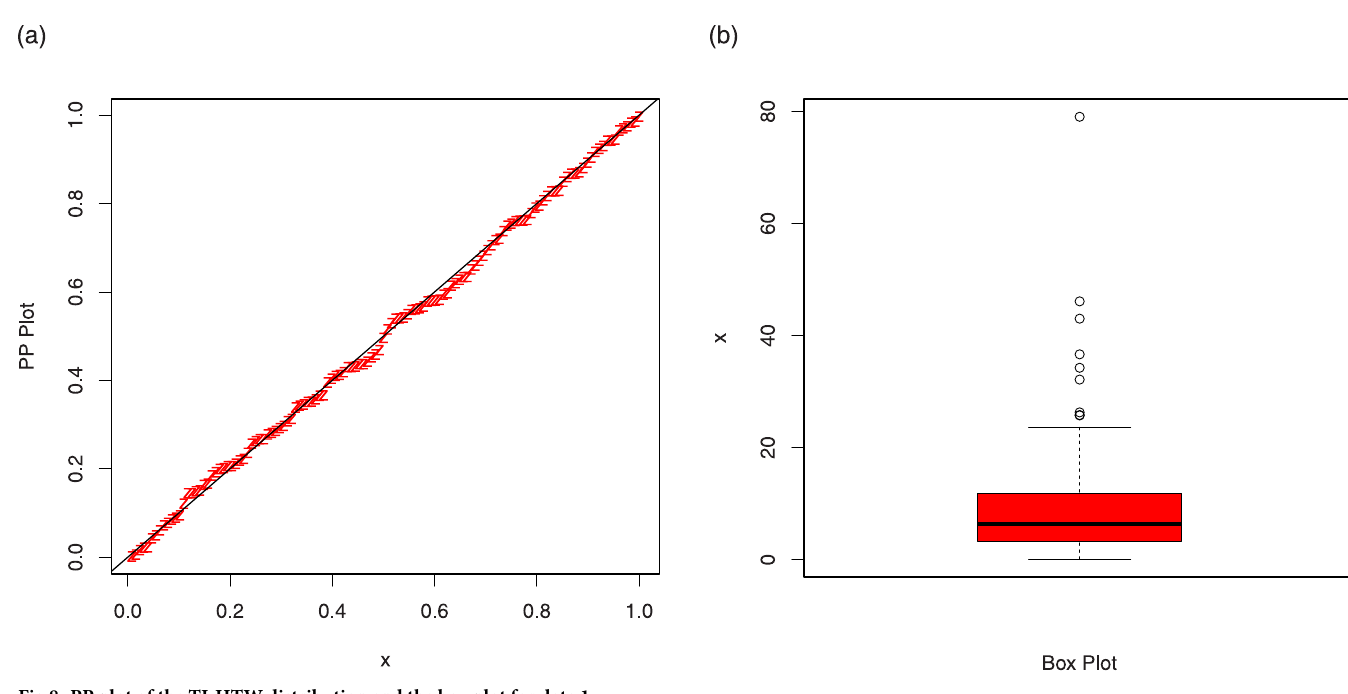
Fig 8. PP plot of the TI-HTW distribution and the box plot for data 1.